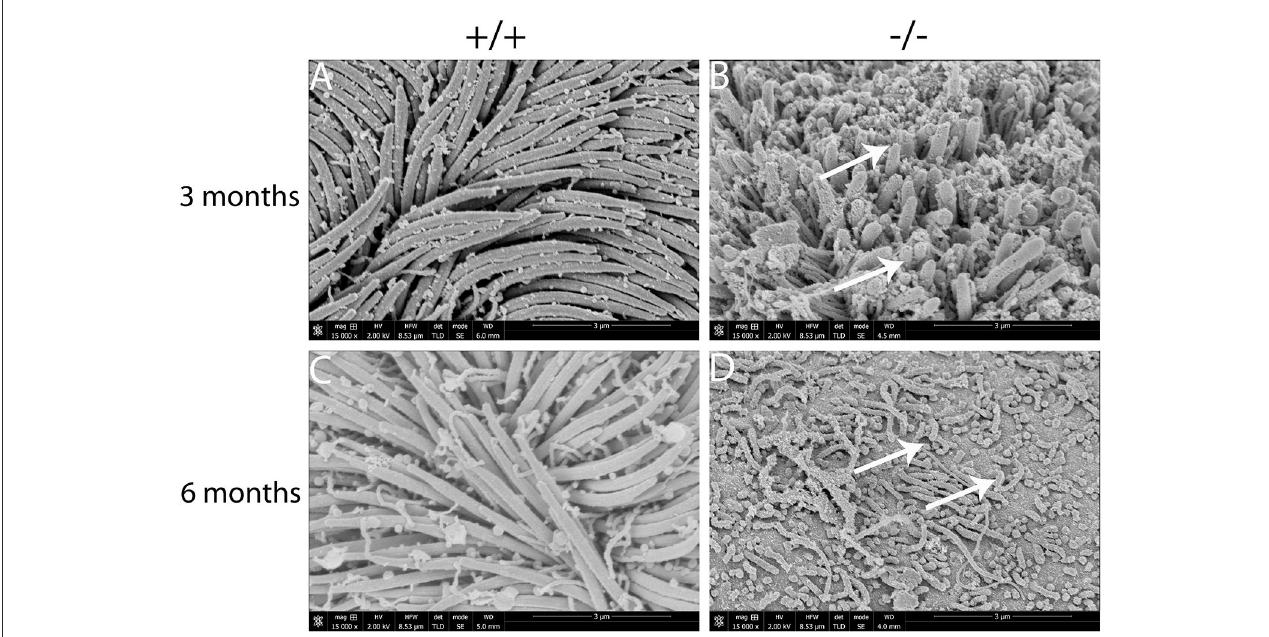
FIGURE7 Scanning electron microscopy (SEM) observation of the cilia of the middle ear cavity in mutant mice. Wild-type ( + / + ) and mutant mice (-/-) were observed in the SEM of the middle ear at the ages of 3 and 6 months, respectively ( n = 3 for each genotype). Wild-type mice exhibited a thick lawn of morphologically normal and distributed cilia in the mucosa of the middle ear at both time points (A, C) . The cilia of the mucosa of the middle ear in mutant mice were short, impaired, and disrupted (arrows), and the impairment of the cilia progressed to a much greater severity at 6 months than the cilia at 3 months (B, D) . Scale bars: 3 µ m.